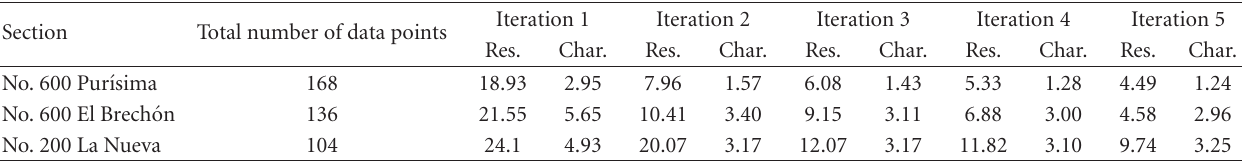
Table 1: Absolute error for each